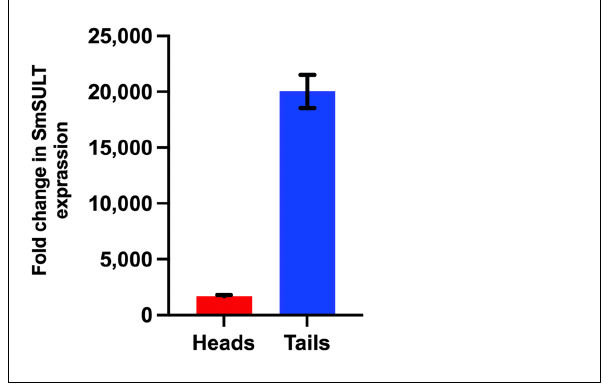
Figure 7. Comparison of SmSULT in cercarial tails vs. heads using qRT-PCR.